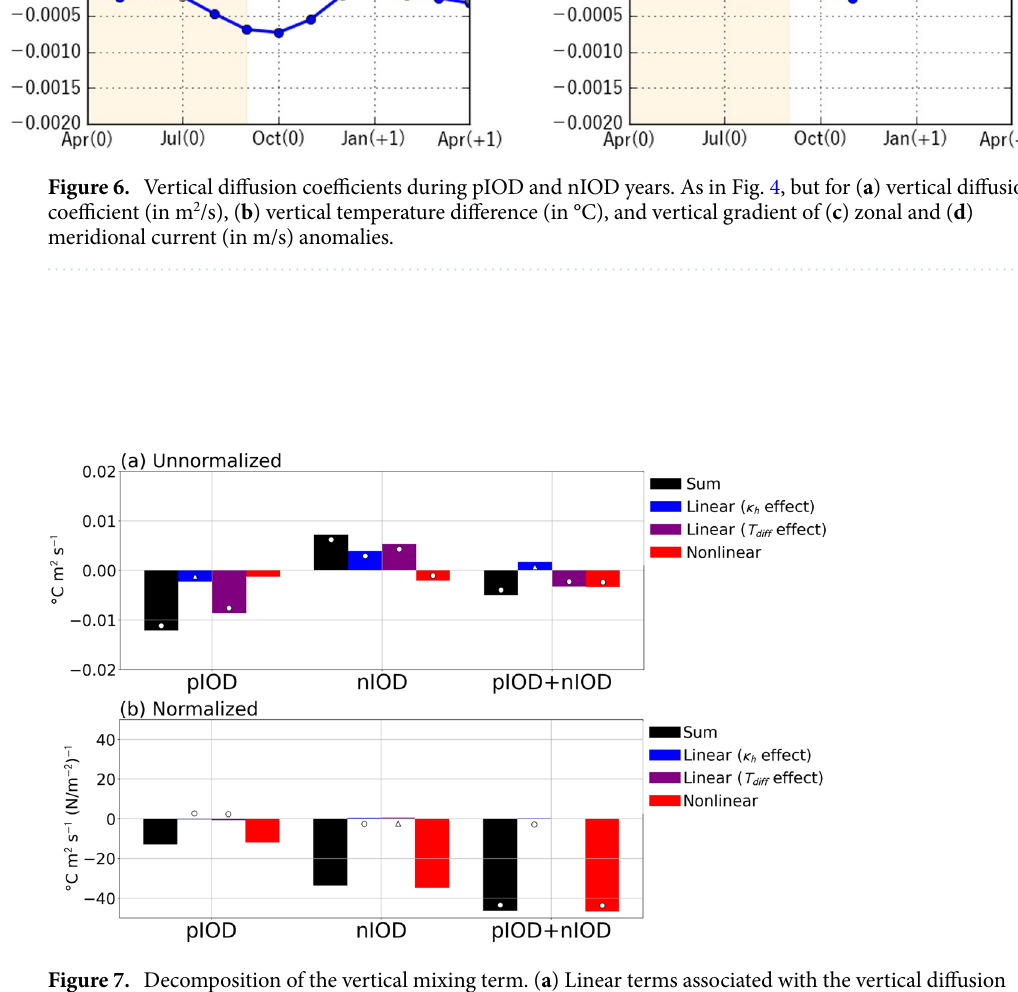
Figure 7. Decomposition of the vertical mixing term. ( a ) Linear terms associated with the vertical diffusion coefficient anomaly (blue; the first term on the right hand side) and the temperature difference anomaly (purple; the second term on the right hand side), nonlinear term (red; the third term on the right hand side), and their sum (black; the left hand side term) in Eq. (3) integrated over the development phase for the pIOD (left) and the nIOD (middle) (in °C m 2 s −1 ). Their sums are also presented (right). ( b ) As in ( a ), but normalized by EQUINOO. The circles (triangles) indicate anomalies significant at the 95% (90%) confidence level by a two- tailed t